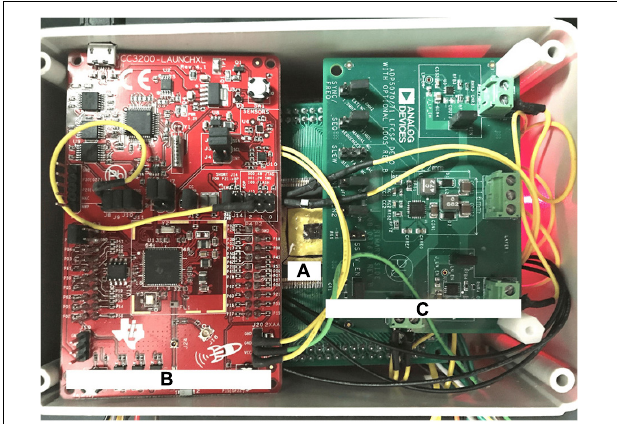
FIGURE 7 | Physical implementation of the wired prototype of the biomimetic stimulator. (A) The stimulator SoC in a Quad Flat Package (QFP). (B) CC3200 Microcontroller Unit (MCU) from the Data Relay circuits. (C) Power relay circuits. Other system components are arranged below the visible